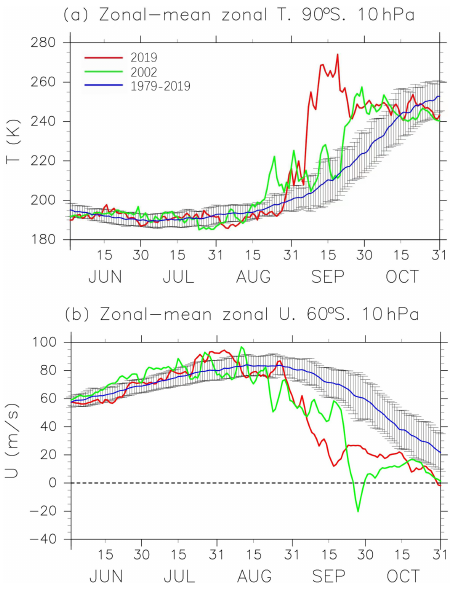
Figure 3. Time series of temperature (K) at 90 ◦ S and 10hPa (a) and zonal-mean zonal wind (ms − 1 ) at 60 ◦ S and 10hPa, (b) from 1 June to 31 October. Climatological values (blue) from 2002 (green) to 2019 (red) are represented with one standard devi- ation shown by error